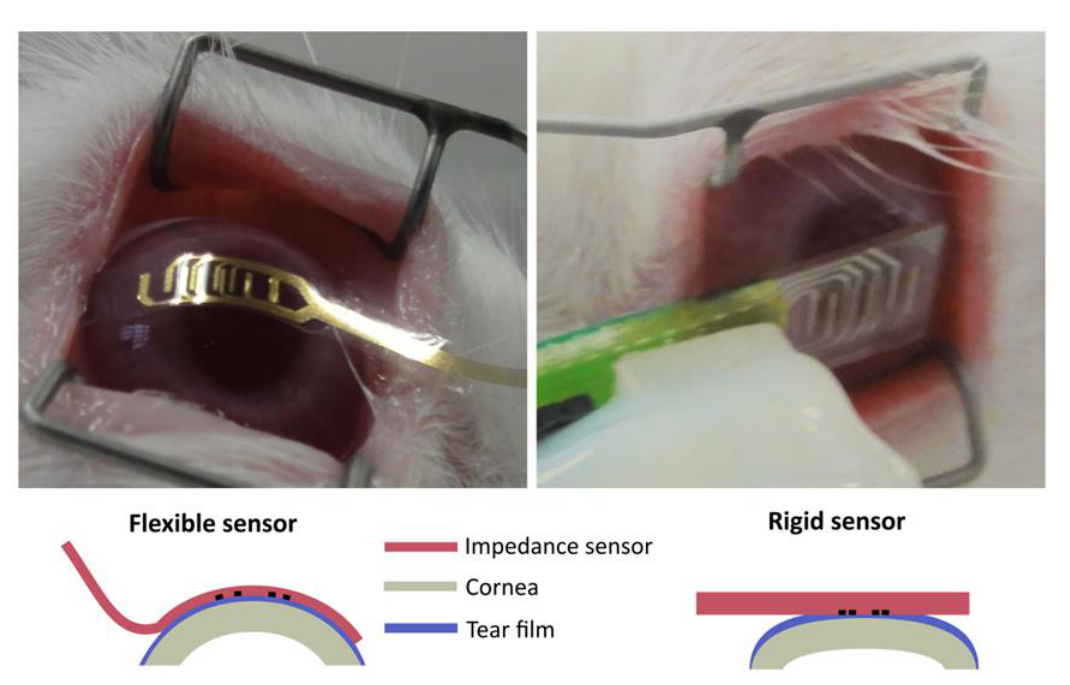
Figure 1. Image and sketch representation of how the impedance sensor is applied. It is interesting to note that the tear film distribution should be more homogeneous in the case of the flexible